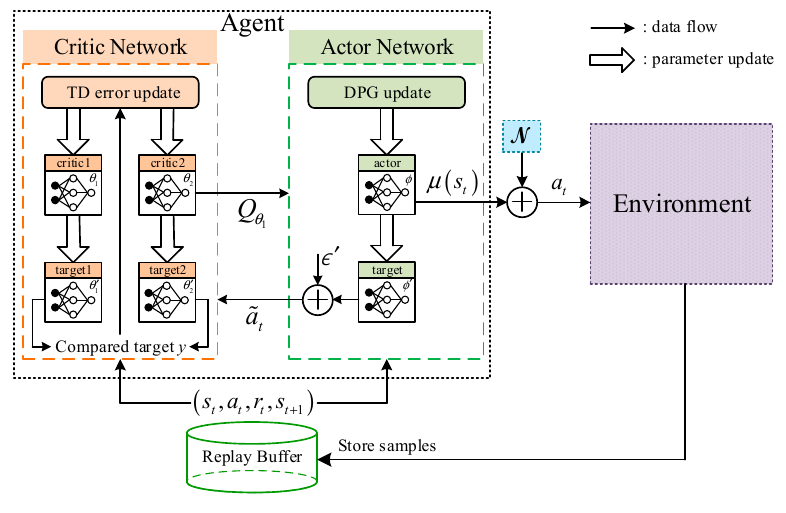
Figure 4. Structure of TD3.